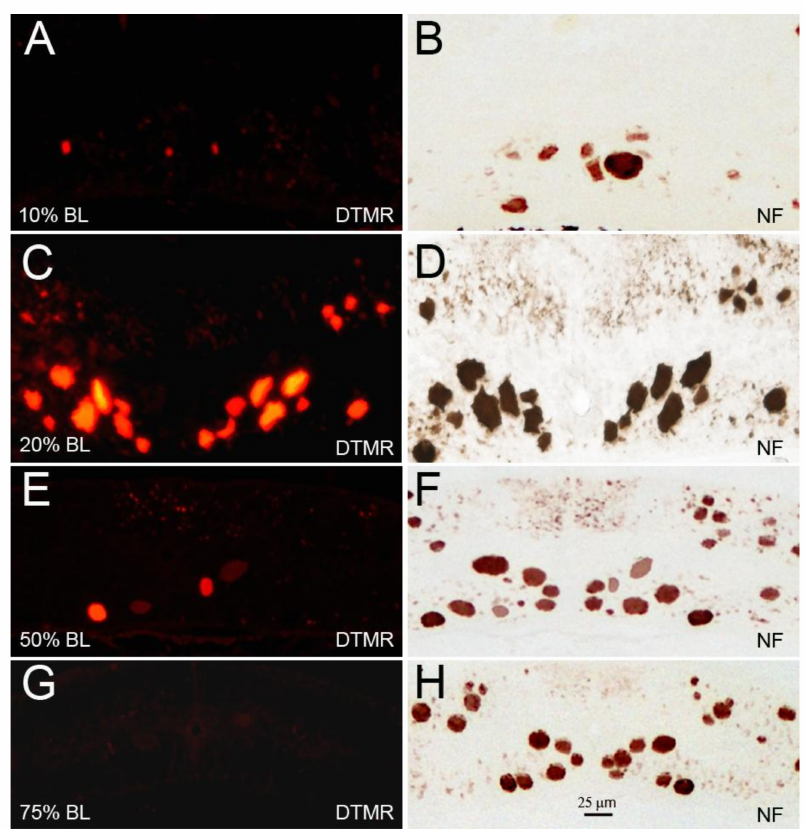
Figure 8. The diameter of RS axons is a determinant of axon resealing time. Spinal cords were transected at 10% ( A , B ), 20% ( C , D ), 50% ( E , F ), or 75% BL ( G , H ). DTMR was applied to the TX sites 24 h post-TX to label late-sealing axons. Transverse sections were obtained 1.5–2 mm rostral to the TX sites 2 h after dye application ( A , C , E , G ). Most of the RS axons had not resealed when the TX was at 20% BL, where axon diameters were maximal. When cut at 75% BL, where axons diameters were the smallest, all axons had resealed; ( B , D , F , H ) the same sections were stained with an anti-NF antibody to show both the sealed and the non-sealed